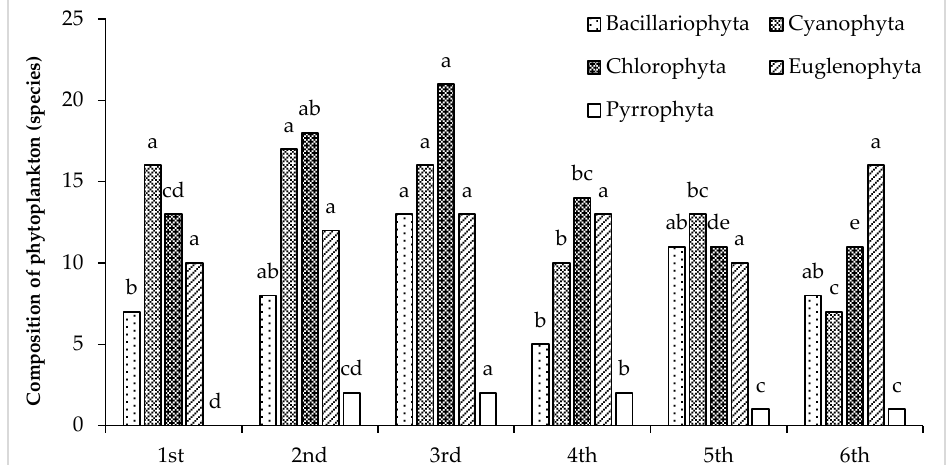
Figure 3. Temporal distribution of phytoplankton in the combined rice-shrimp system over sampling intervals. Note: Different letters a, b, c, d indicates significantly different at a significance level of 5%. Table 1 presents the spatial and temporal distribution of the observed phytoplankton phyla in terms of the number of identified species. At the first sampling interval, the num- ber of species of both Cyanophyta and Chlorophyta in the rice area (S2 and S3) tended to be higher than the numbers found within the water sampled from the shrimp ditches (S4 and S5). In contrast, by the time of the 3rd and 4th sampling intervals, the assemblage of both Chlorophyta and Cyanophyta were found in the rice area (S2 and S3), yet still tended to be less than that of shrimp ditches (S4 and S5). This spatial difference could be explained by the growing canopy of the rice plants, resulting in less light penetration, and thus a less favorable condition for phytoplankton growth (especially Chlorophyta), in comparison to the open shrimp ditches [27]. Table 1. The spatial and temporal composition of phytoplankton (number of species).